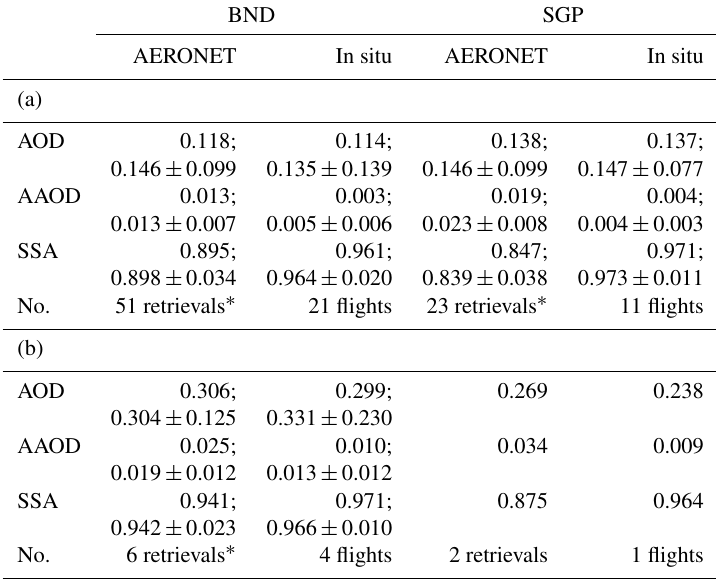
Table 1. (a) Statistical values (medians, means and standard deviations) of AERONET versus in situ comparison where there was an AERONET retrieval within ± 3h of the end of a 2h flight profile. AERONET values are for Level 1.5 data when there was a Level 2 AOD value and an almucantar retrieval. (First value in each cell is median; second set of values in each cell are mean ± SD; third row is number of AERONET retrievals corresponding to flights (in AERONET columns) or number of flights (in situ columns).) These numbers represent the blue points in Figs. 4–6. (b) Statistical values (medians, means and standard deviations) of AERONET versus in situ compari- son where there was an AERONET retrieval within ± 3h of the end of a 2h flight profile and AERONET AOD 440 >0.2. AERONET values are for Level 1.5 data when there was a Level 2 AOD value and an almucantar retrieval. (First value in each cell is median; second set of values in each cell are mean ± SD; third row is number of AERONET retrievals corresponding to flights (in AERONET columns) or number of flights (in situ columns).) These numbers represent the purple points in Figs. 5–6.